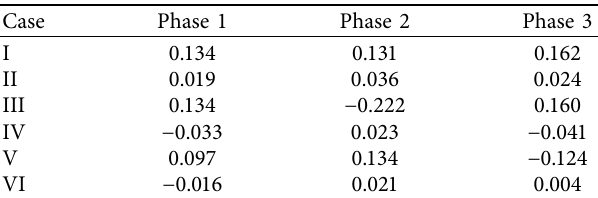
Table 4: Reactive power generation of the distribution